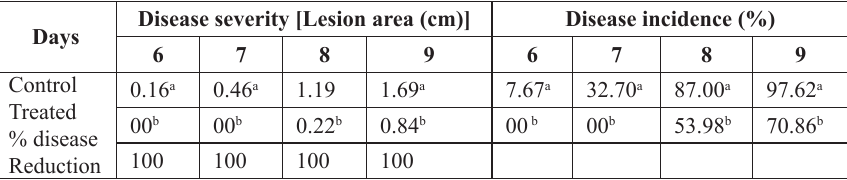
Table 4: Effect of potassium silicate soil-drench treatments (200mg/l) on severity and anthracnose disease incidence in challenge inoculated C. annum (cv. CA-8) with C. acutatum